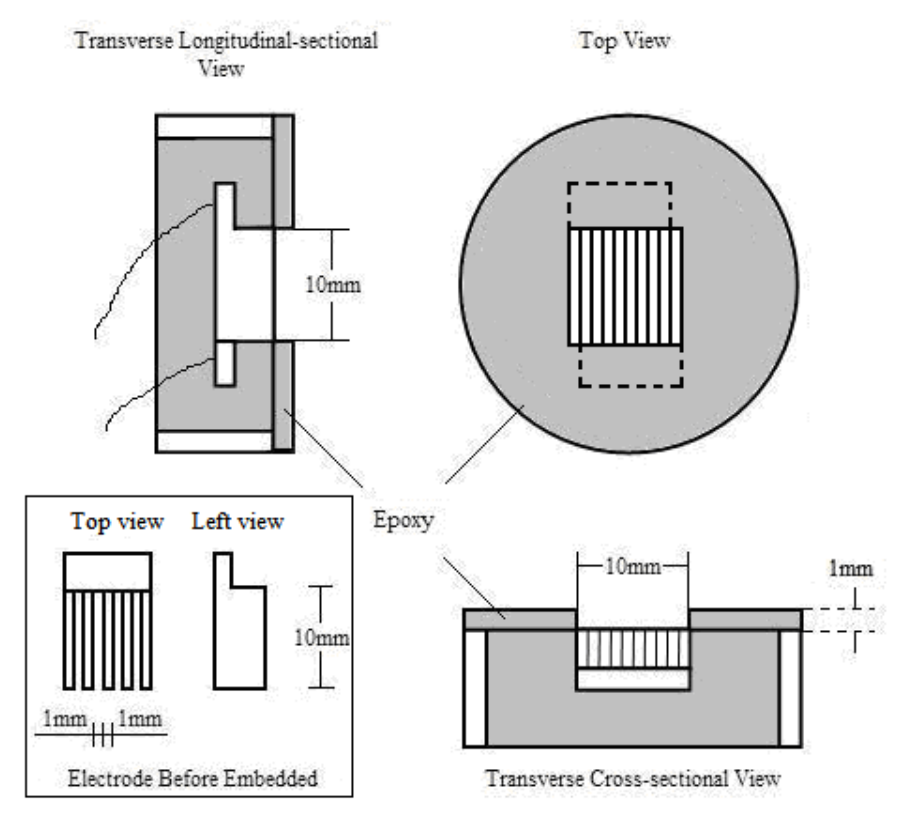
Figure 1. Schematic diagrams of the two-electrode cell used for EIS